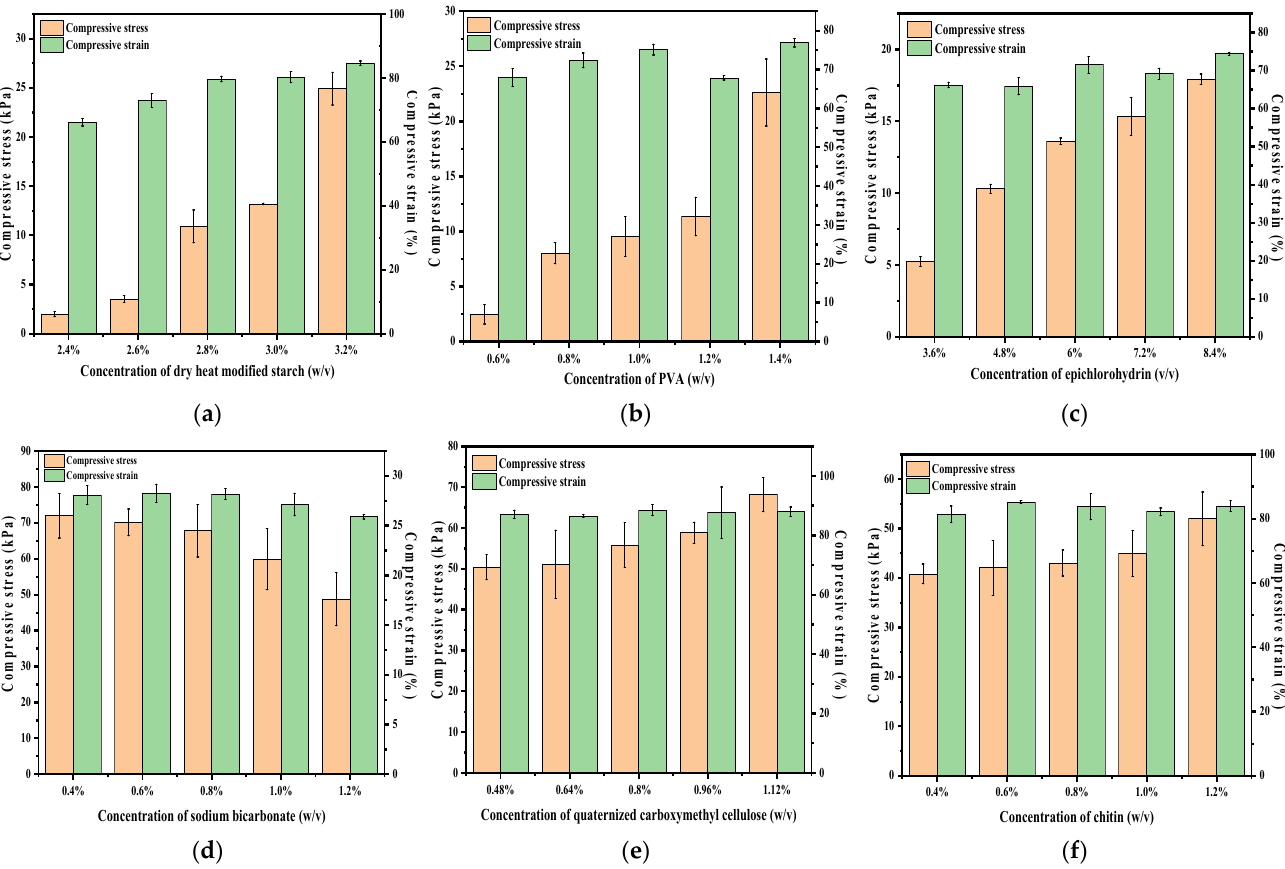
Figure 3. Compression tests of hydrogels with different component concentrations: ( a ) dry heat- modified starch, ( b ) polyvinyl alcohol, ( c ) epichlorohydrin, ( d ) sodium bicarbonate, ( e ) quaternized carboxymethyl cellulose, and ( f ) chitin.